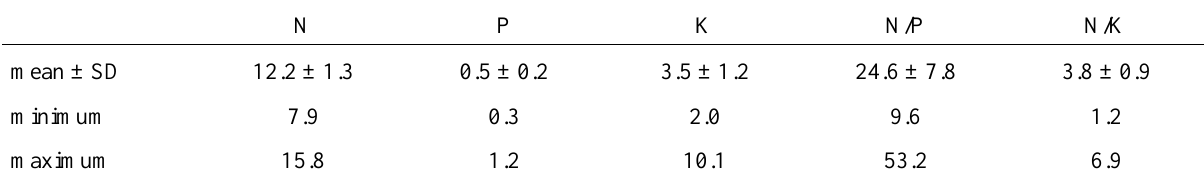
Figure 11. Development of mean Sphagnum papillosum lawn thickness measured at five points in each plot (green) and mean total Sphagnum biomass (dry mass ± SD) over time (dark blue) at the Ramsloh study site. The bars (left bar 2010–2011, right bar 2011–2012) are divided into one-year biomass production (light blue) and residual biomass of previous years (brown) (in g m -2 ). The number of samples is written next to each mean value. Table 3. Nutrient concentrations (mg g -1 , dry mass basis) and quotients in the capitula of Sphagnum papillosum (uppermost 1 cm) in October 2010, six years after installation of the Sphagnum farming site ( n =